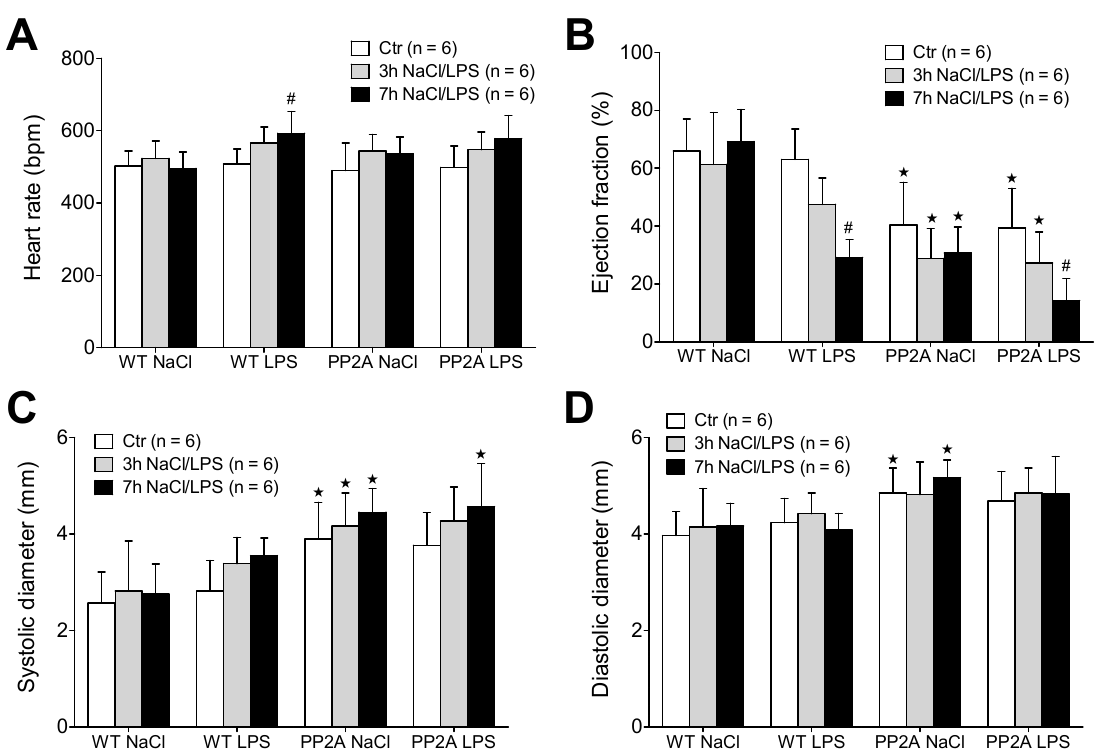
Figure 3. Echocardiography after LPS. Measurement of echocardiographic parameters of wild type (WT) and PP2A overexpressing mice before (Ctr) and 3 and 7 h after intraperitoneal application of LPS (25 mg/kg) or NaCl solution as solvent control. ( A ) Heart rate, ( B ) ejection fraction, ( C ) maximal systolic cardiac diameter of the left ventricle, ( D ) maximal diastolic cardiac diameter of the left ventricle of the heart. First bars always indicate basal conditions (before application of LPS), second bars indicate three hours after application of LPS or solvent control (NaCl). Third bars indicate seven hours after application of LPS or solvent control (NaCl). Numbers in brackets indicate the number of experiments. ★ p < 0.05 vs. WT; # p < 0.05 vs. NaCl.